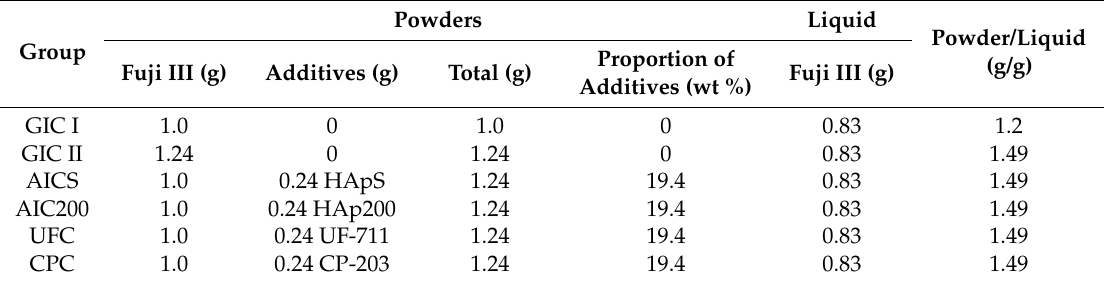
Table 2. The formulations of specimens used in Experiment